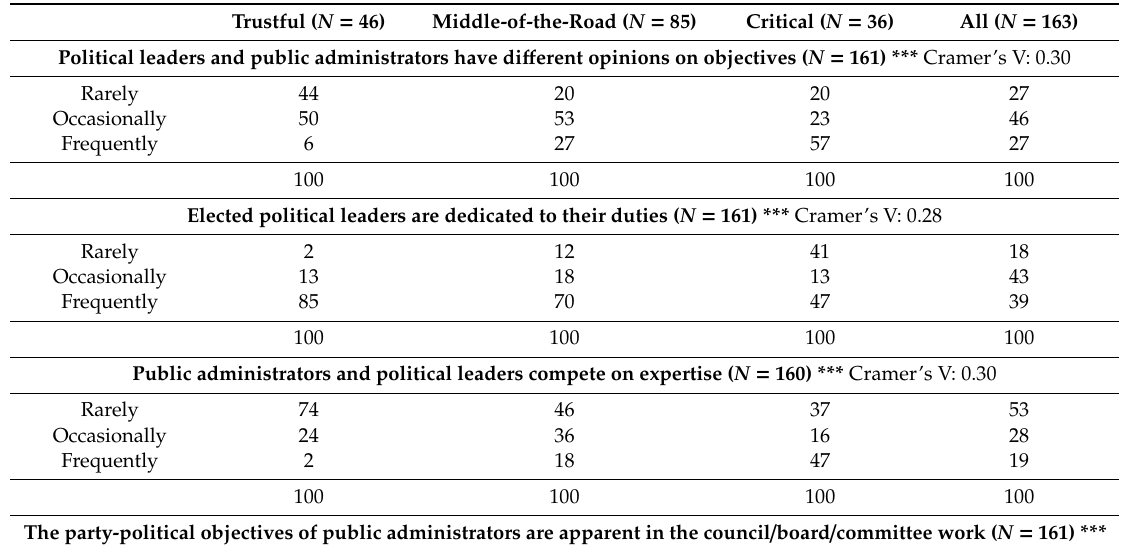
Table 5. How often are the following issues evident in the work of your council / board / committee (%)? Questions on interests and